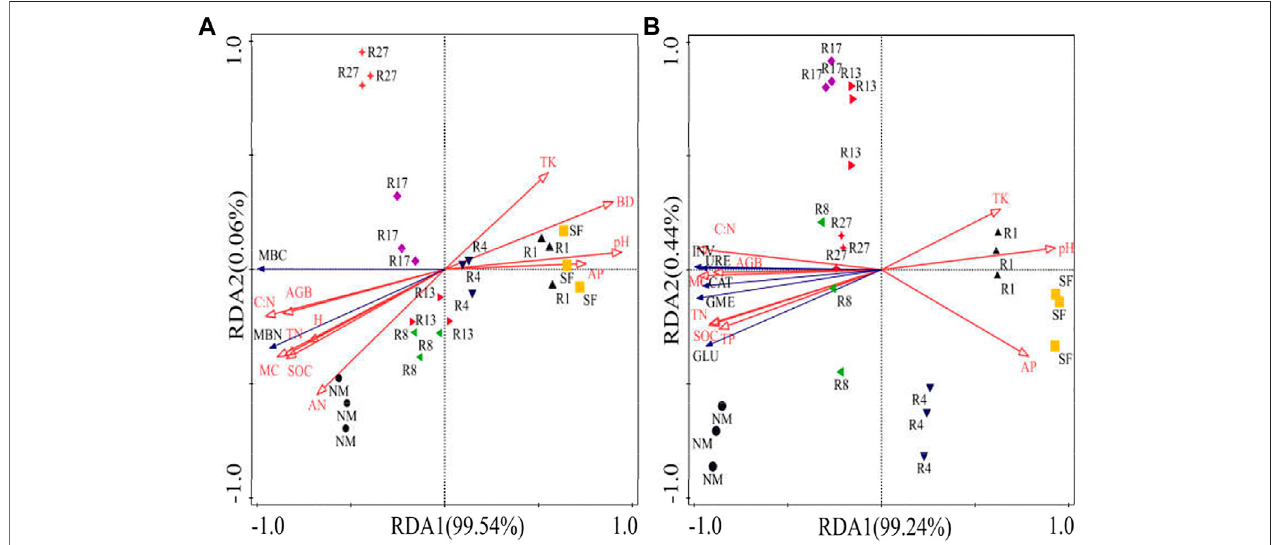
FIGURE 6 | Redundancy analysis (RDA) of the effect of soil physico-chemical properties and plant properties on soil microbial biomass (A) and enzyme activities (B) . BD, bulk density; MC, moisture content; SOC, soil organic carbon; TN, total nitrogen; AN, available nitrogen; TP, total phosphorus; AP, available phosphorus; TK, total potassium; AGB, aboveground biomass; H, plant height; MBC, microbial biomass carbon; MBN, microbial biomass nitrogen; GLU, β -glucosidase; INV, invertase; CAT, catalase; URE, urease; GME, geometric mean of enzyme activity.